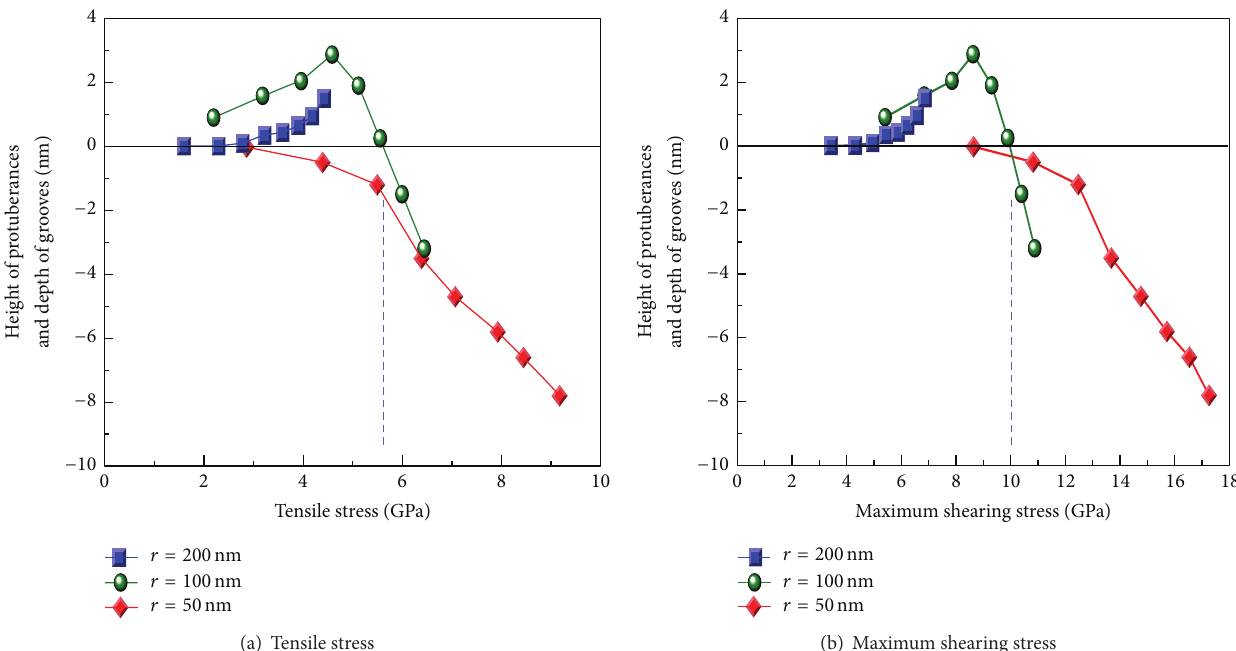
Figure 9: Contact stress effects on protuberance heights and groove depths. (a) Tensile stress effect and (b) maximum shear stress effect.